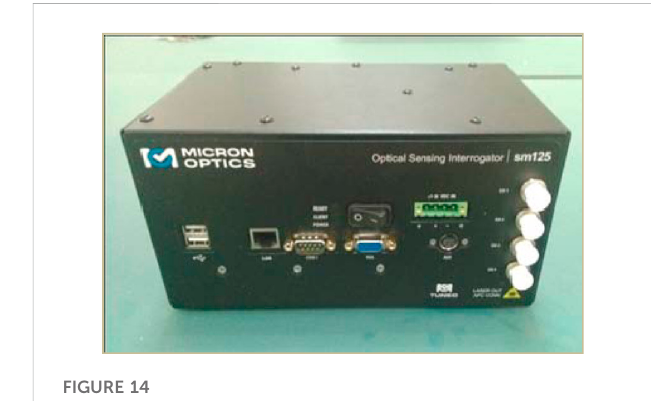
FIGURE 14 Fiber Bragg grating static